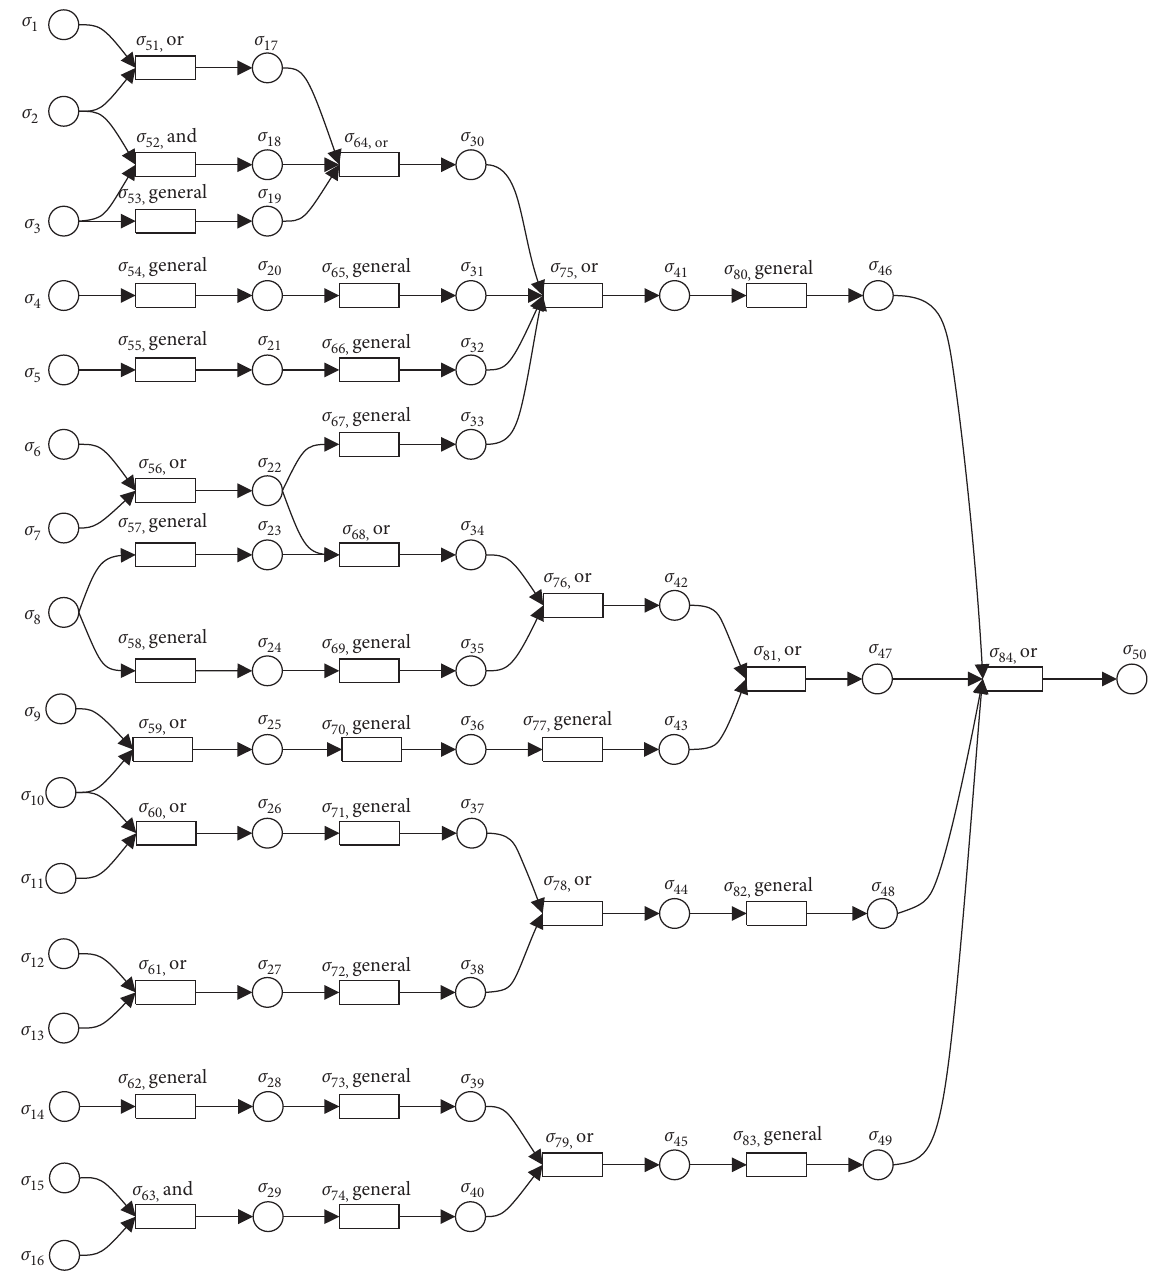
Figure 3: An rMFRSNPS-based model for three-phase induction